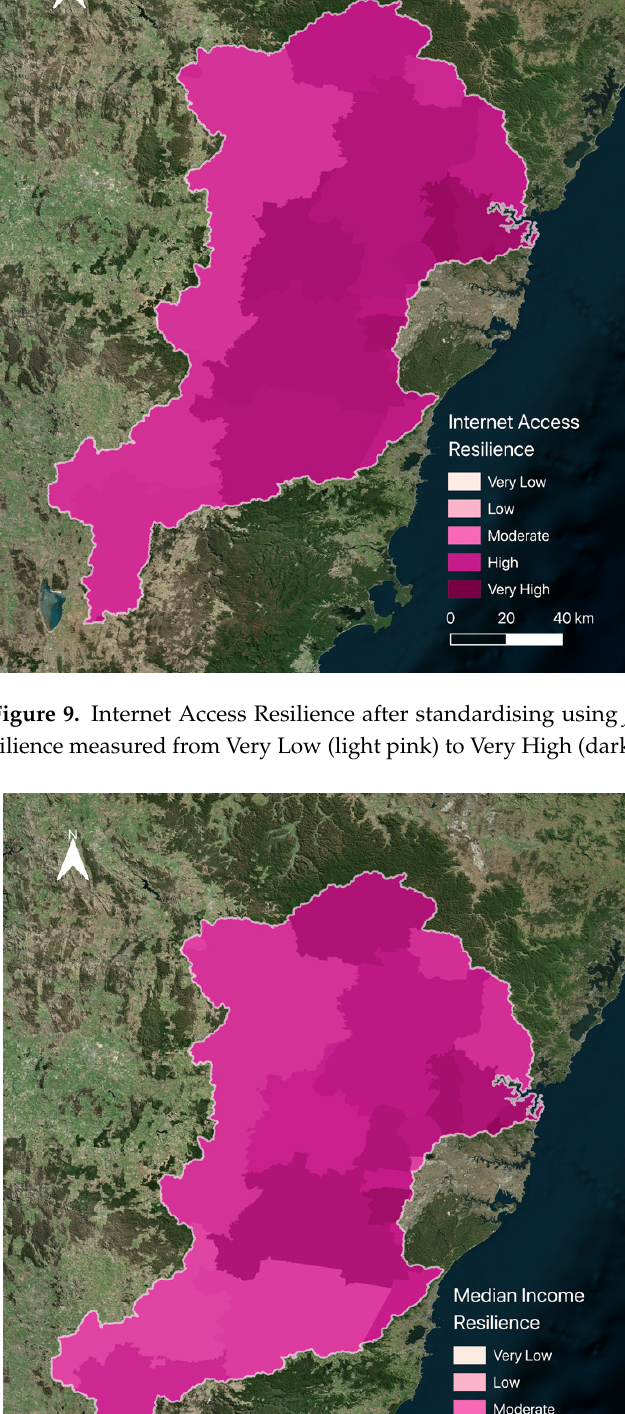
Figure 11. Flood Project Resilience after standardising using fuzzy membership processing. Resili- ence measured from Very Low (light pink) to Very High (dark pink).